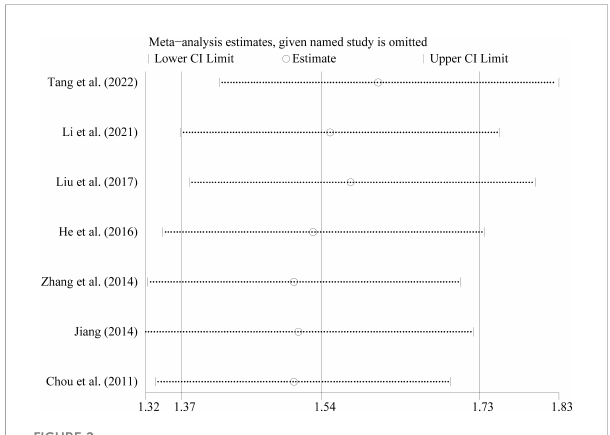
FIGURE 2 Sensitivity analysis of the included studies The abscissa refer to the RR and the ordinate represented each study and